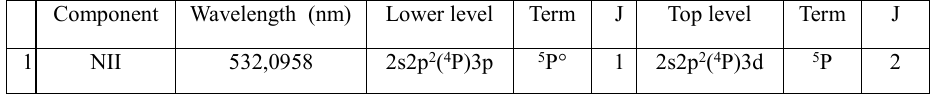
Table 1. Dipole transition of an excited nitrogen ion in the laser emission band